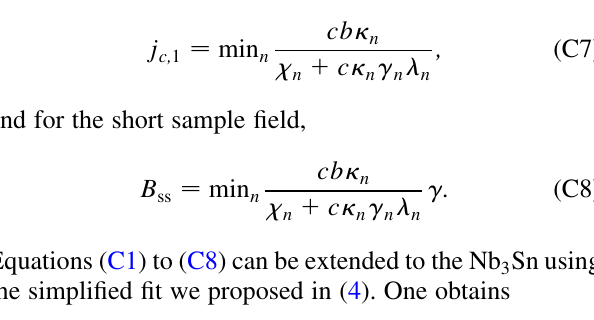
FIG. 16. One-parameter family for a single layer shell that